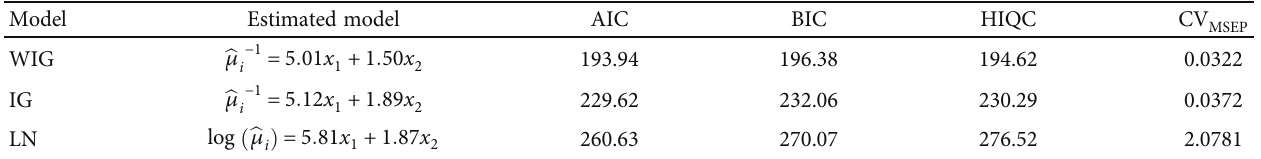
criteria for di ff erent